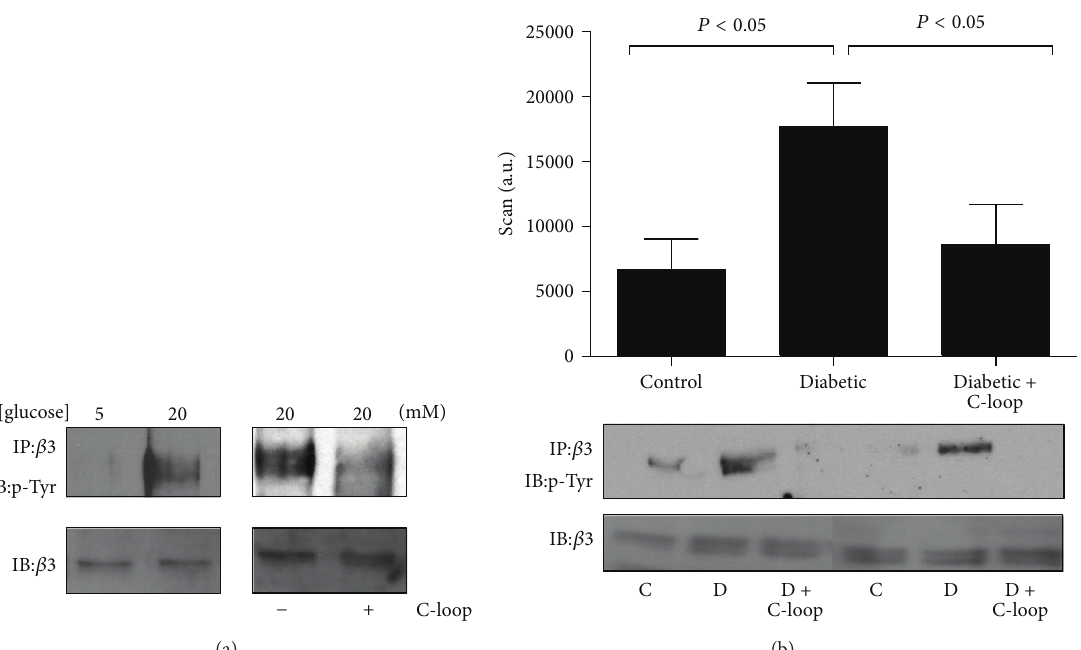
Figure 5: (a) Hyperglycemia increases 𝛽 3 phosphorylation in microvascular endothelial cells. Left panel: lysates from microvascular endothelial cells grown in 5 or 20mM glucose were immunoprecipitated (IP) with an anti- 𝛽 3 antibody and immunoblotted (IB) with an anti-phosphotyrosine antibody (p-Tyr). To demonstrate that equal amounts of 𝛽 3 in each treatment condition were analyzed, equal amounts of protein from the two lysates were immunoblotted directly for 𝛽 3. Right panel: microvascular endothelial cells grown in 20 mM glucose were incubated with (+) or without ( − ) the C-loop 𝛽 3 antibody for 4 hours prior to being immunoprecipitated (IP) with an anti- 𝛽 3 antibody and immunoblotted (IB) with an anti-phosphotyrosine antibody (p-Tyr). To demonstrate equal amounts of 𝛽 3 in each treatment condition, equal amounts of protein from the two lysates were immunoblotted directly for 𝛽 3. (b) 𝛽 3 phosphorylation in rat kidney lysates. Kidney lysates from control rats, vehicle-treated diabetic rats, or diabetic rats treated with C-loop antibody were immunoprecipitated (IP) with an anti- 𝛽 3 antibody, separated by SDS-PAGE, and immunoblotted (IB) with an anti-phosphotyrosine antibody (p-Tyr). To demonstrate that this was not due to differences in the total amount of 𝛽 3 in each sample equal amounts of protein were also immunoblotted directly for total 𝛽 3. For each treatment group the phosphorylated protein band intensities from all the rats in the group ( 𝑛 = 15 ) were quantified using scanning densitometry. The arbitrary scanning units (mean ± SEM) are represented graphically and an example from 2 animals from each treatment group is shown below the graph. 𝑃 < 0.05 when the extent of 𝛽 3 phosphorylation is compared between the control (con) and the untreated diabetic group (D), or the untreated diabetic group is compared to the diabetic group treated with C-loop antibody (D + C-loop).